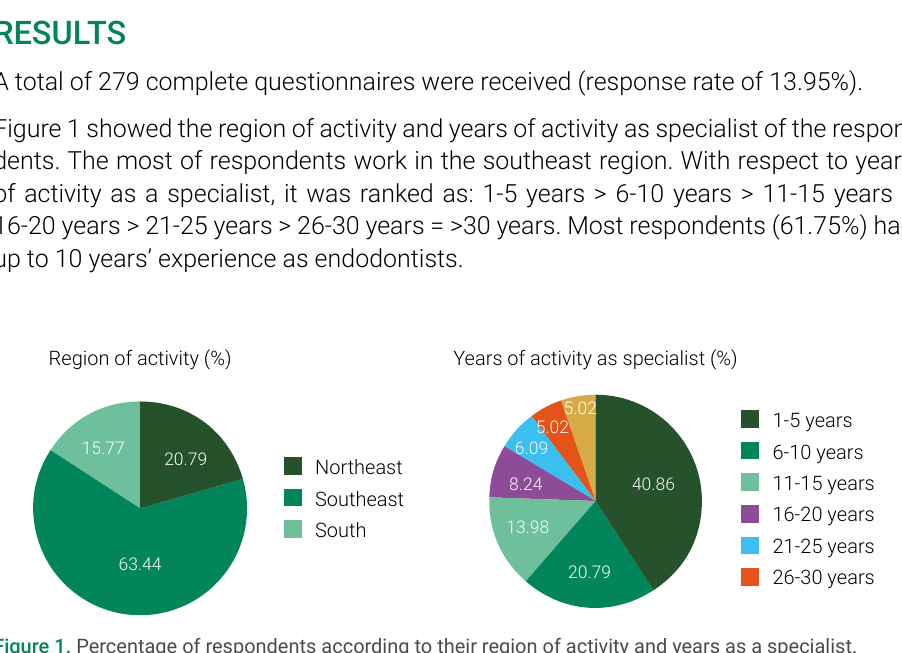
Figure 1. Percentage of respondents according to their region of activity and years as a specialist.